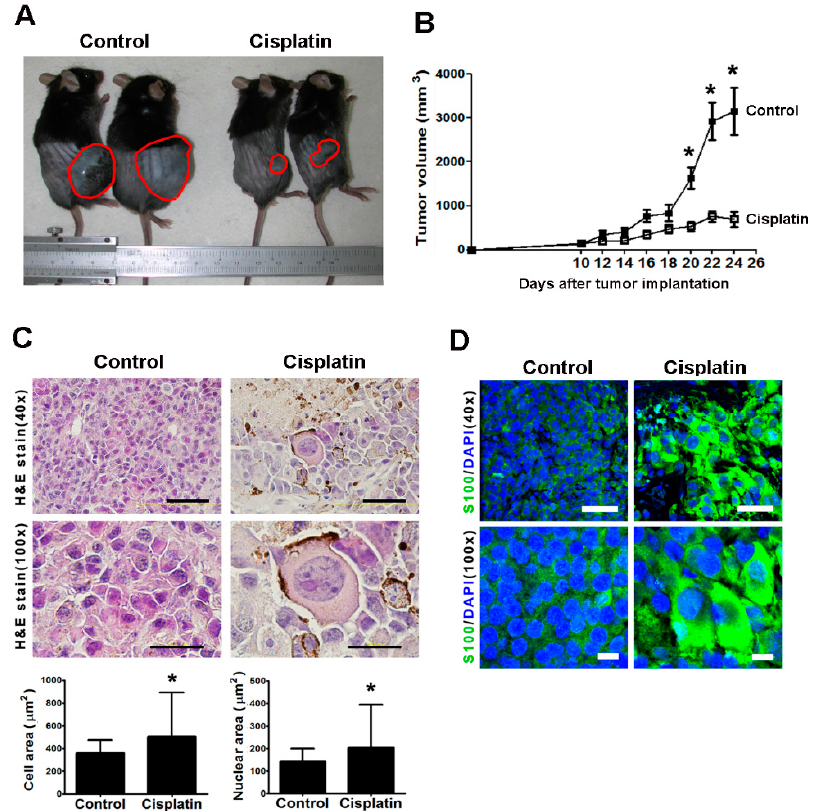
Figure 1. The existence of giant cells in cisplatin-treated B16-F10 melanoma in vivo. Tumors were induced through the subcutaneous transplantation of B16-F10 cells in C57/BL mice. ( A ) PBS-treated (control) and cisplatin-treated xenografted mice were anesthetized and shaved before being sacrificed. The red circles denote the tumor margins. ( B ) The tumor volumes in the mice (control group, n = 12; cisplatin-treated group, n = 12) were measured at the indicated time. ( C ) The tumors slices were stained with HE and observed by microscope with 40- and 100-fold magnifications. Scale bars, 100 µ m and 50 µ m at 40-fold and 100-fold magnifications, respectively. The areas of the cells and the nuclei were quantified using software (the measured cell number > 500, each group). ( D ) The tumor slices were immunostained by the anti-S100 antibody (green), and the nuclei were stained with DAPI (blue). Scale bars, 50 µ m (top panel) and 10 µ m (bottom panel). * p < 0.05 compared with the control group.